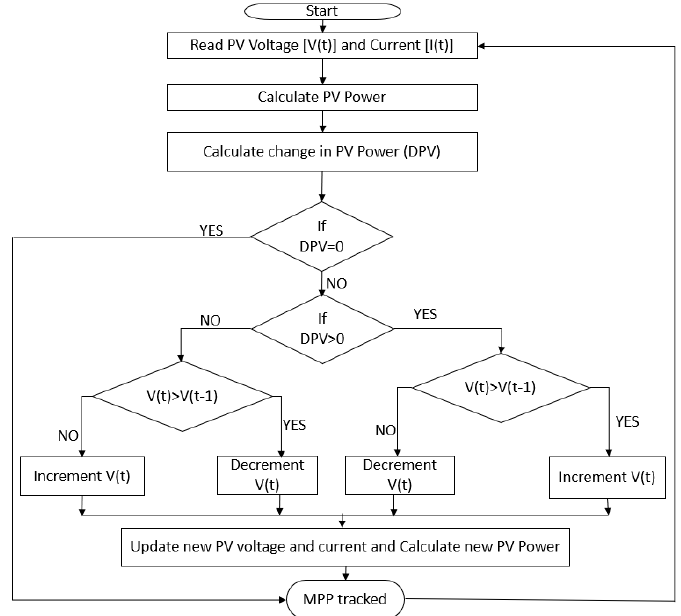
Figure 3. P&O method’s flow diagram [44]